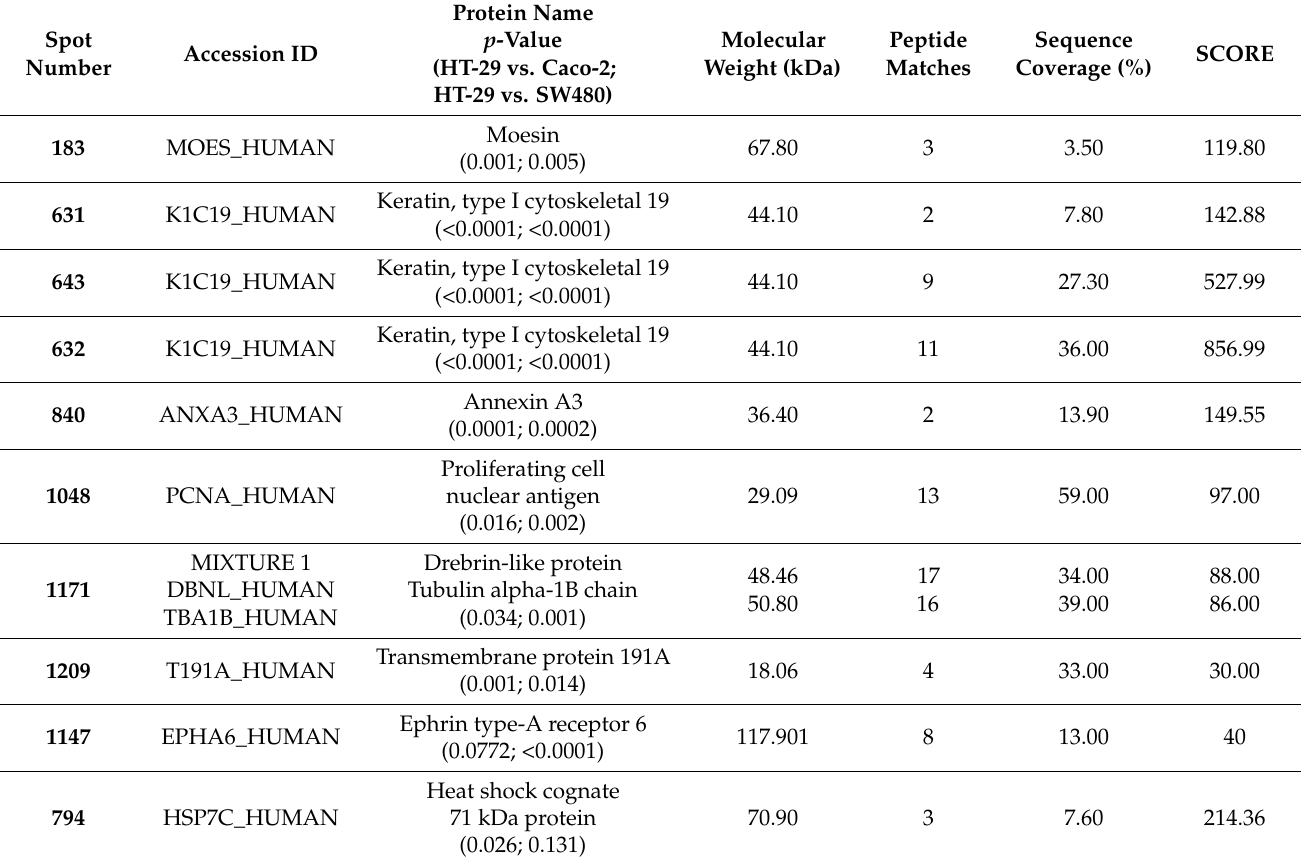
Table 2. List of differentially down-regulated proteins with statistical significance ( p < 0.05) in BRAFV600E mutant HT-29 cells in comparison to Caco-2 and SW480 colon cancer